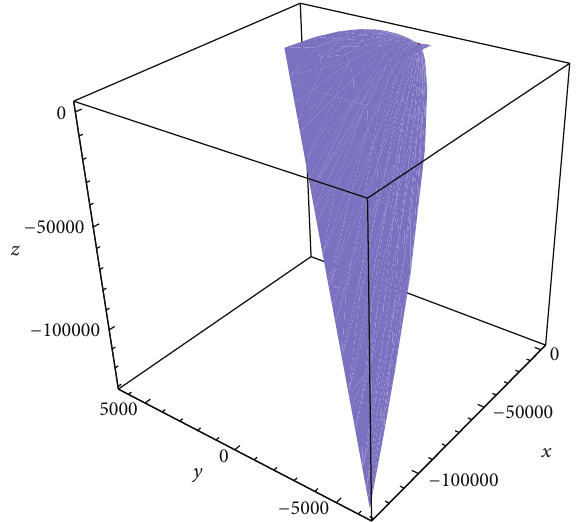
Figure 2: A member of surface family for 𝛾 = 1 and 𝛿 = 1 and the curve 𝛼 .